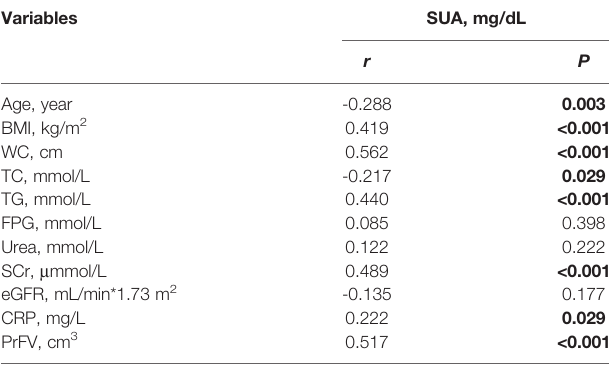
TABLE 2 | Correlations between SUA and clinical variables in the study population. Variables